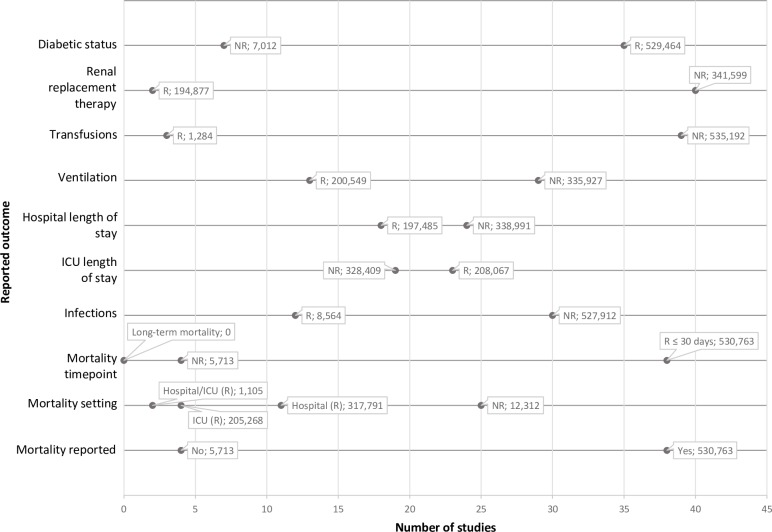
Distribution of study characteristics and outcomes in observational studies conducted in trauma and mixed ICUs.Callouts might overlap for label categories with the same number of studies. ICU, intensive care unit; NR, not reported; R, reported.